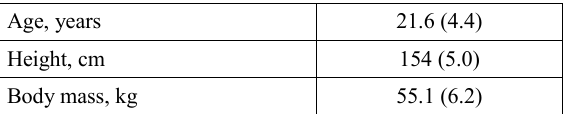
Table 1. Anthropometric characteristics and age of aerobic gymnasts (mean